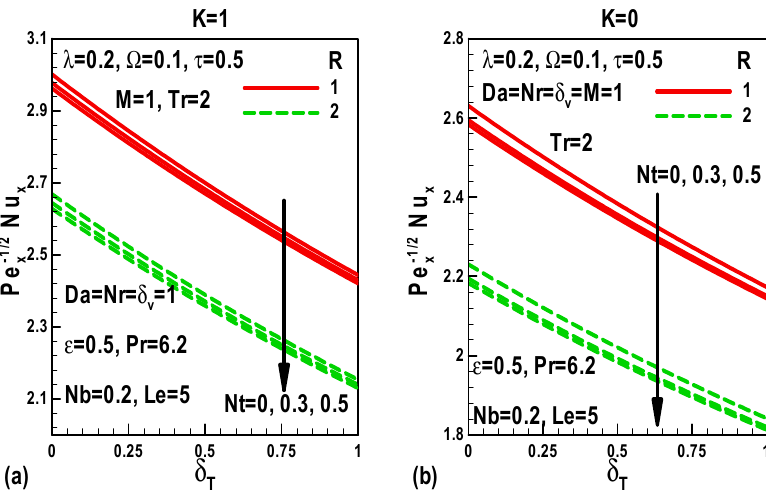
Figure 14. E ff ects of thermal slip, radiation, and thermophoresis parameters on Nusselt numbers ( a ) with pressure gradient and ( b ) without pressure